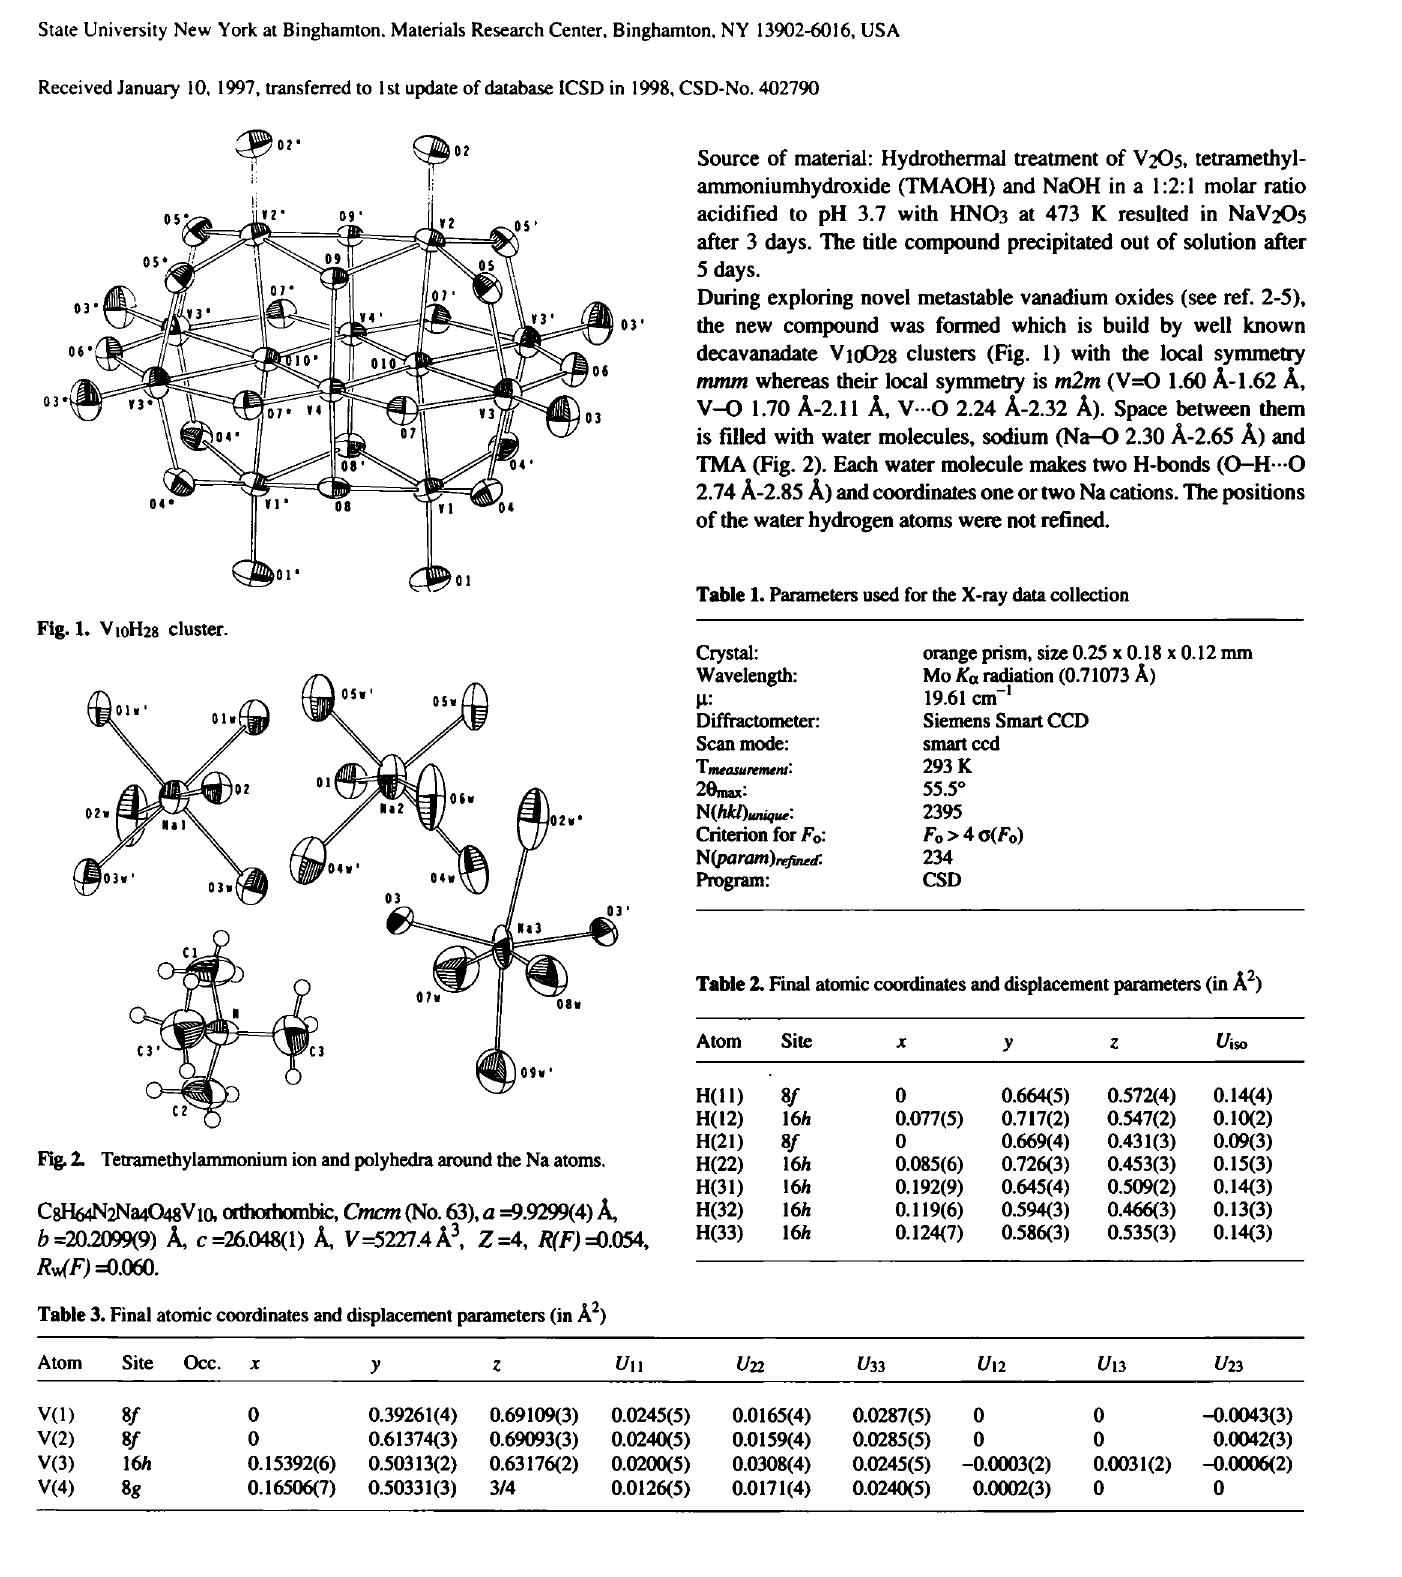
Fig. 2. Tetramethylammonium ion and polyhedra around the Na atoms. CgH64N2Na4048Via orthortiombic, Cmcm (No. 63), a =9.9299(4) Â, b =202099(9) Â, c =26.048(1) Â, V=5227.4 Â 3 , Ζ =4, R(F)= 0.054, Rv/F) =0.060. Table 3. Final atomic coordinates and displacement parameters (in Â 2 )